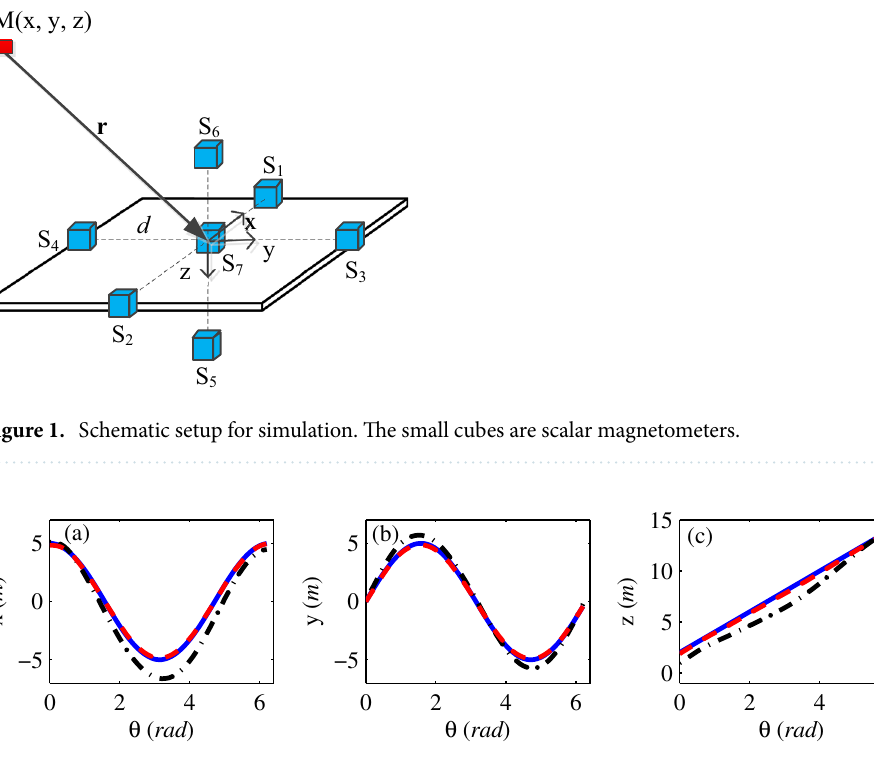
Figure 2. The estimated positions of ( a ) x-axis, ( b ) y-axis and ( c )